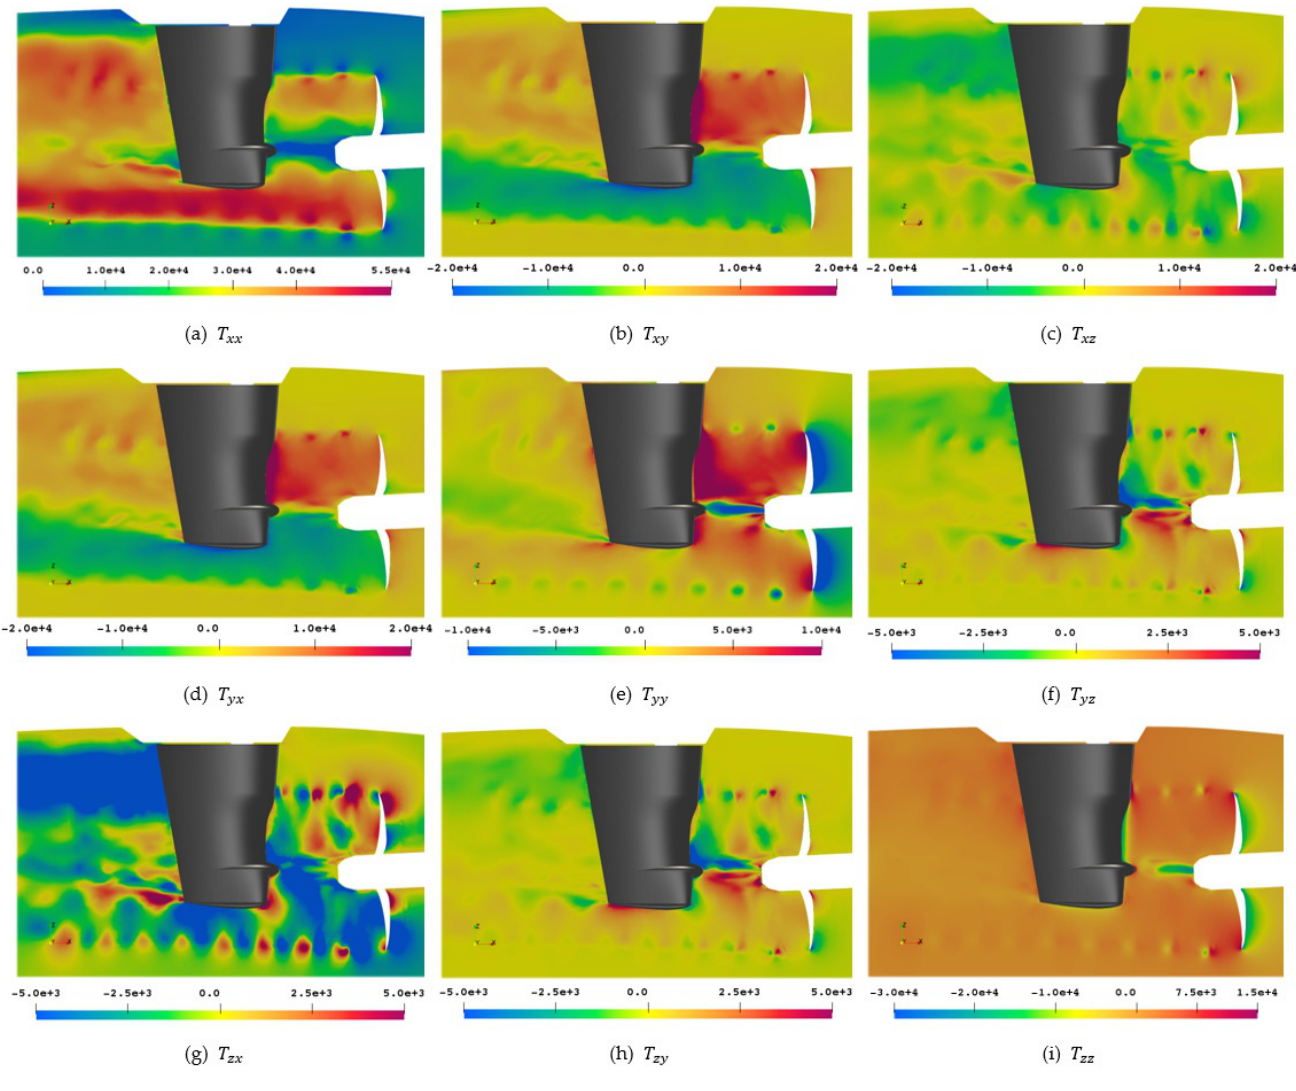
Figure 23. Lighthill stress tensor 𝑇 (cid:3036)(cid:3037) in [Kg/ms (cid:2870) ].